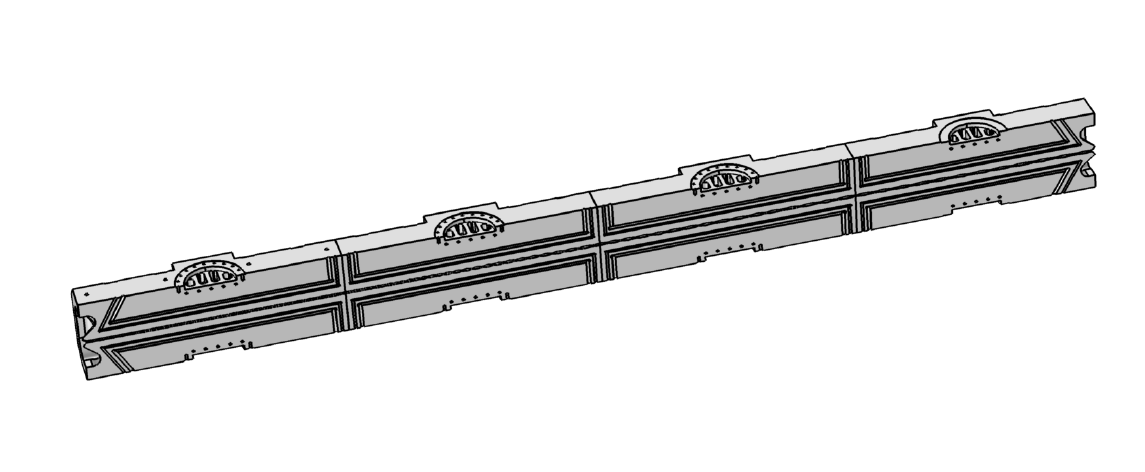
Figure 11. Longitudinal cross section of the RFQ structure. The four segments can be seen, showing the cooling channels and the vacuum ports.